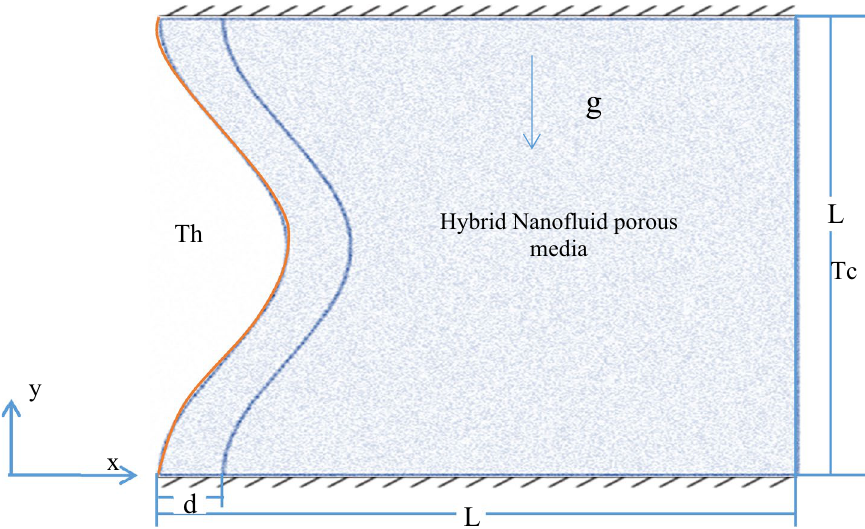
Figure 1. Schematic configuration of the present problem.